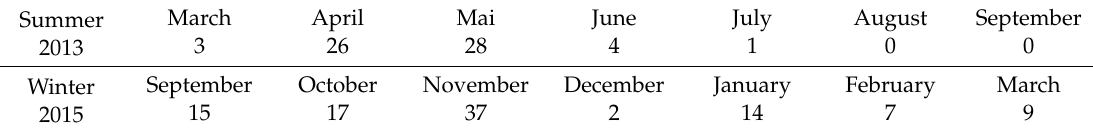
Table 3. The distribution of hourly time steps across the two seasons of the